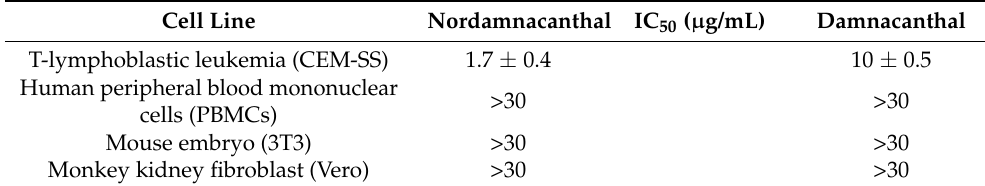
Table 1. Cytotoxicity of nordamnacanthal and damnacanthal against different cell lines based on IC 50 values determined by the MTT